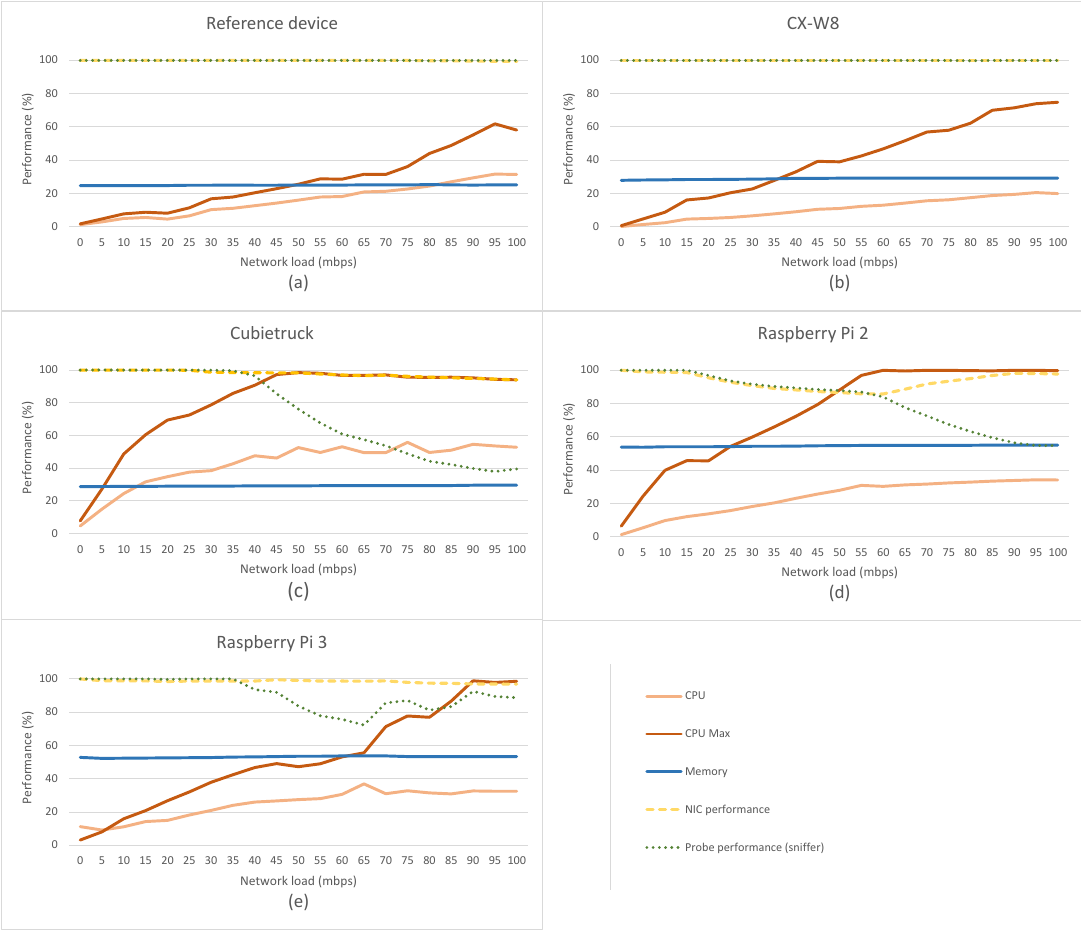
Figure 8. Result of the tests for prototypes: ( a ) reference device; ( b ) CX-W8; ( c ) Cubietruck; ( d ) Raspberry Pi 2; and ( e ) Raspberry Pi 3.